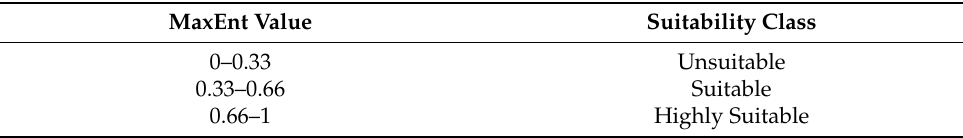
Table 2. Javan leopard habitat suitability classes.